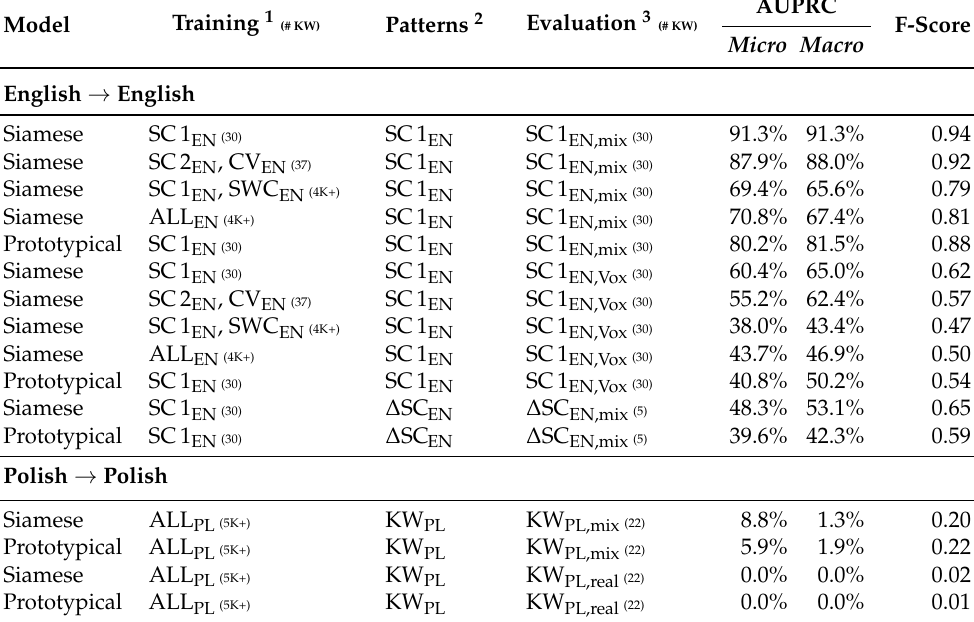
Table 4. Keyword detection performance for models trained and evaluated in monolingual scenarios. The Area Under Precision–Recall Curve is based on the keyword classes present in the search patterns. We report it either with micro- or macro-averaging. The F-score column represents the best result achieved by the model across different settings of the detection threshold. All models use the default detector